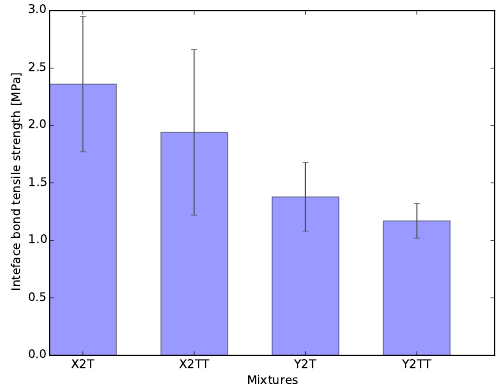
Figure 14. Average layer interface tensile bond